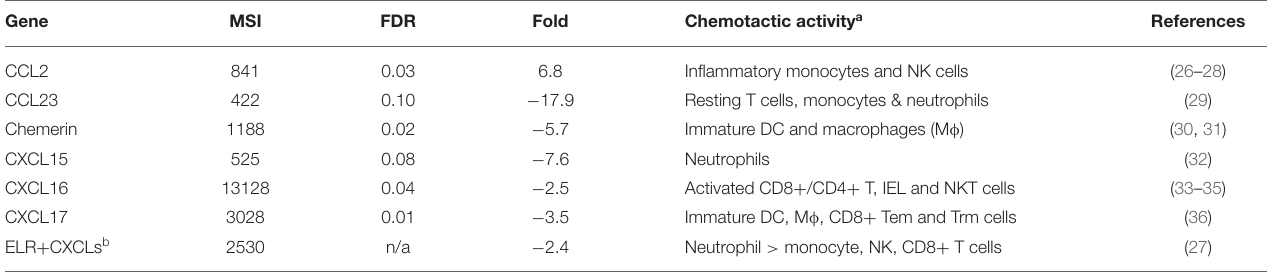
TABLE 2 | Mean expression levels (microarray signal intensity, MSI), false discovery rates (FDR), fold differences ( + and – values as up- and down-regulated in carriers compared to non-carriers, respectively) and chemotactic activities of chemokine genes differentially expressed between the nasopharynx epithelia of carriers and